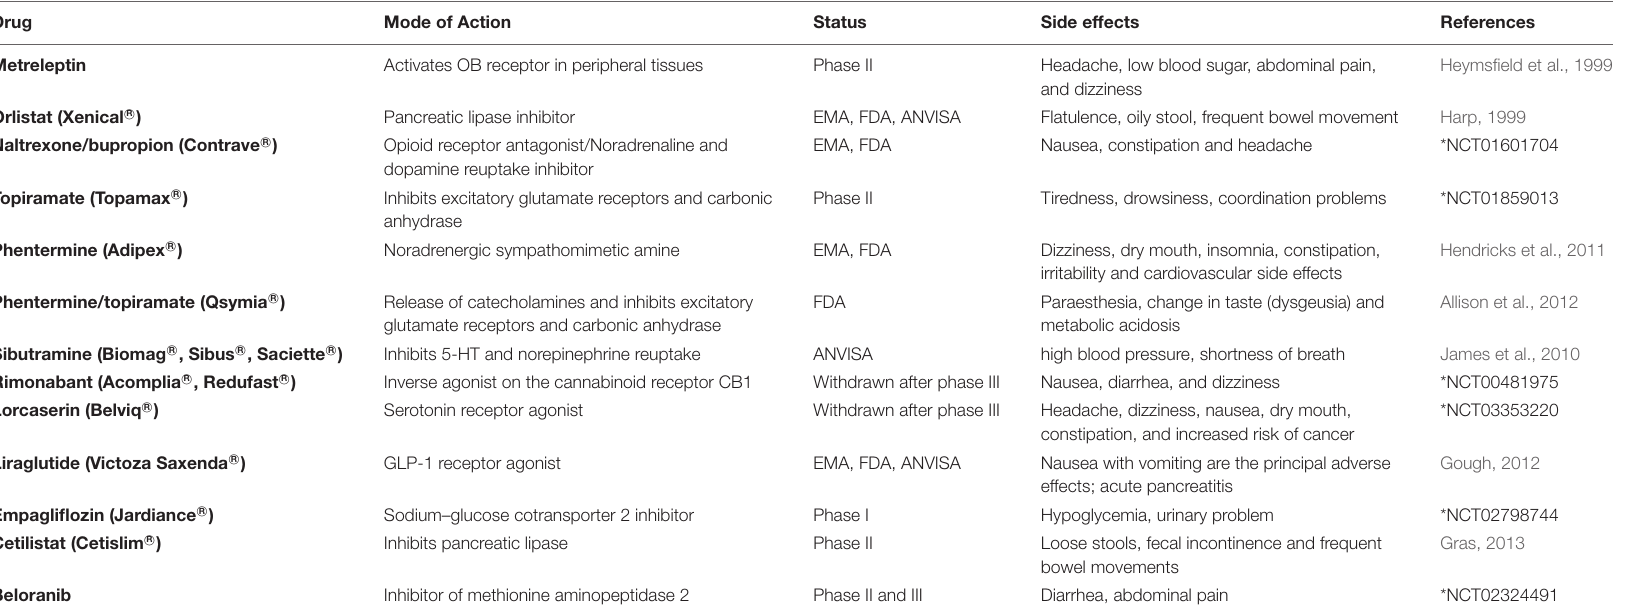
TABLE 2 | Drugs and their modes of action in treatment of